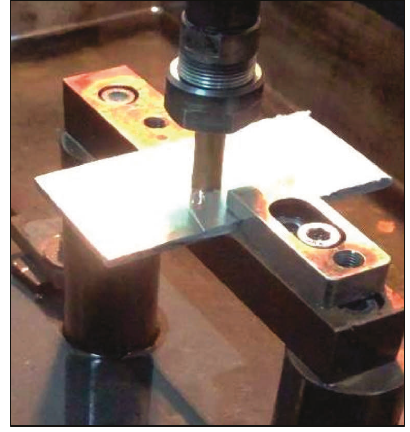
Figure 4: Spark generation.